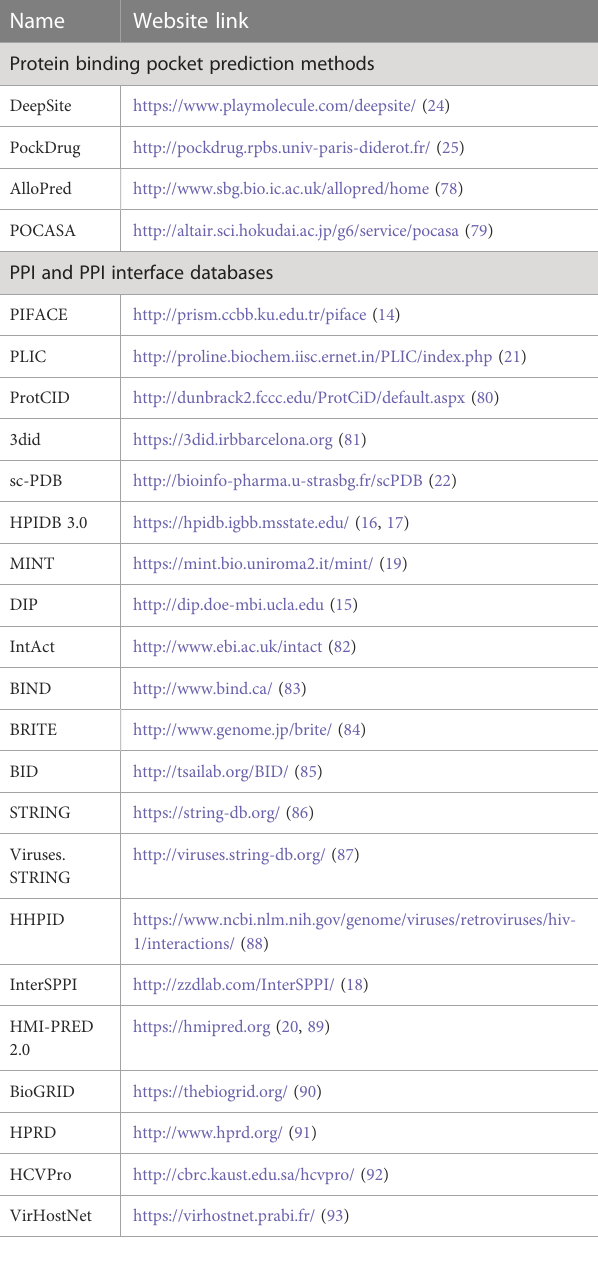
TABLE 1 List of available representative methods/algorithms/databases for protein binding pocket prediction, PPIs and PPI interfaces. Name Website link Protein binding pocket prediction